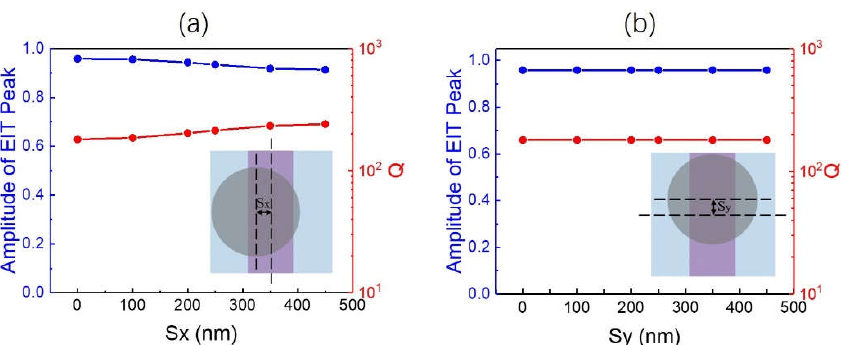
Figure 6. Influence of the relative displacement between the disks and rods in the x-direction S x ( a ) and y -direction S y ( b ) on the EIT performance when P x = P y = 900 nm, w 1 =335 nm, r 2 = 328 nm and t = 600 nm.